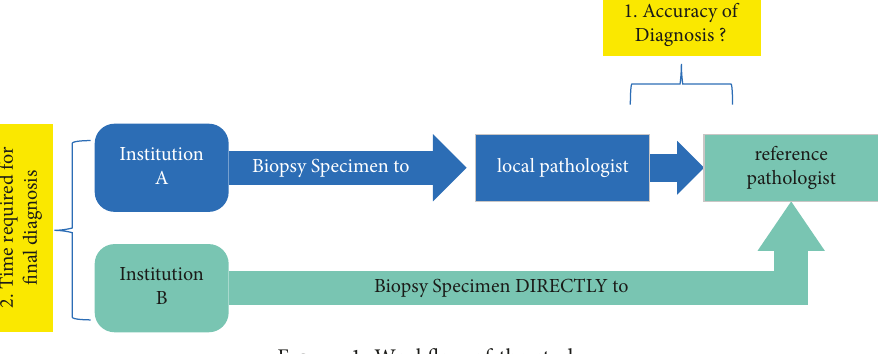
Figure 1: Workflow of the